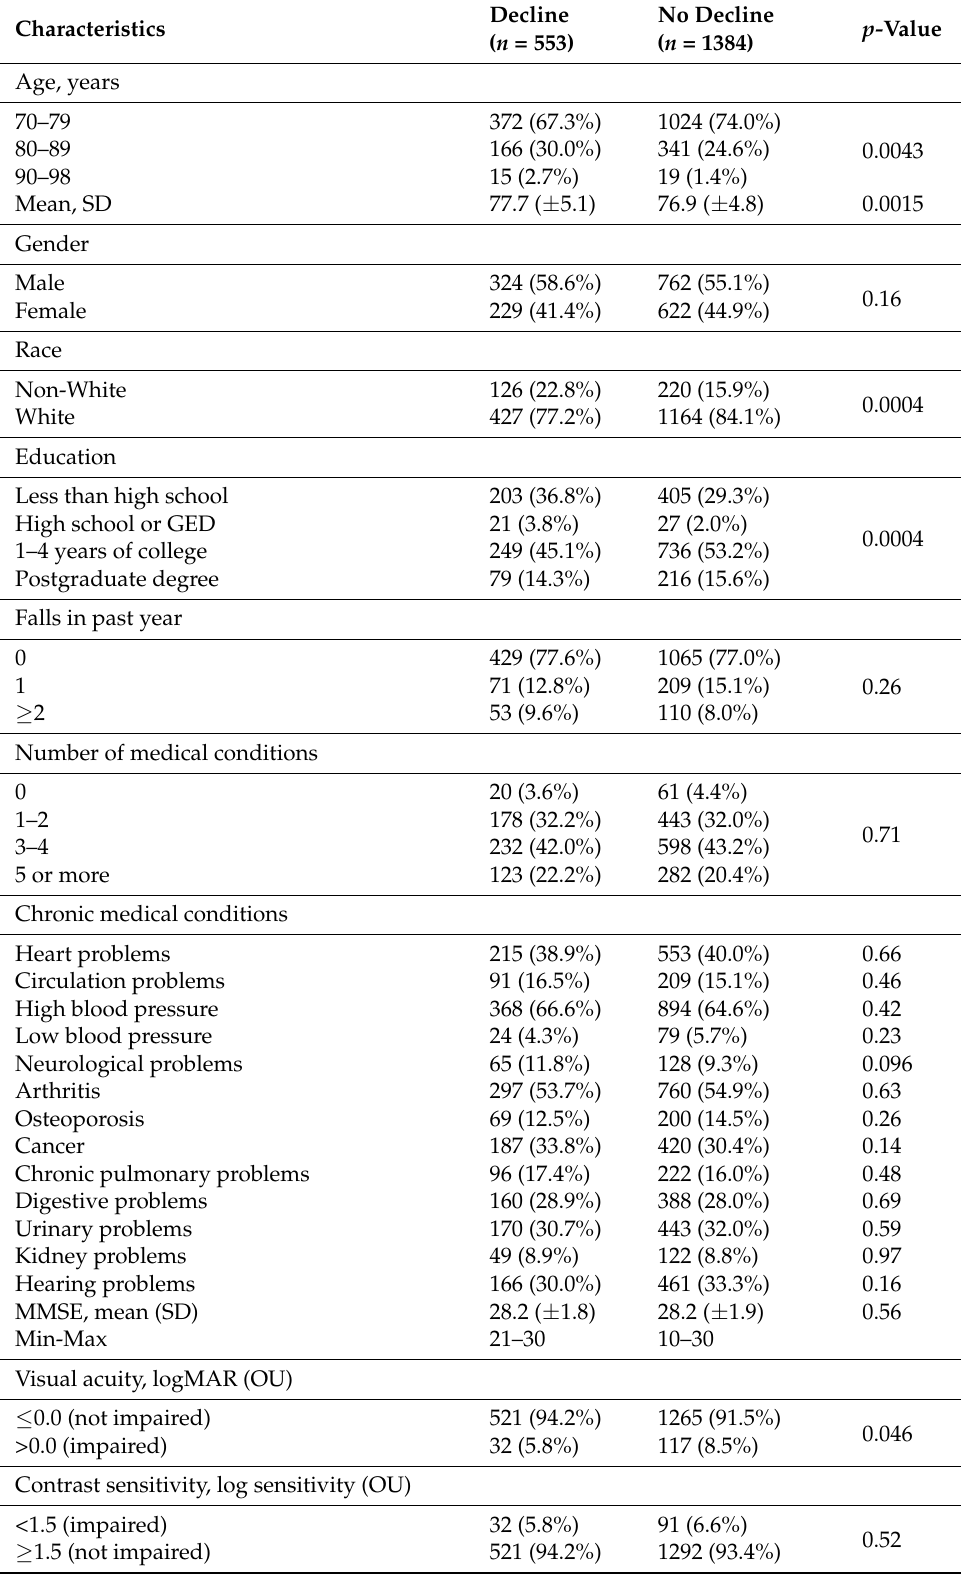
Table 4. Baseline characteristics of drivers with or without decline in function ( N =